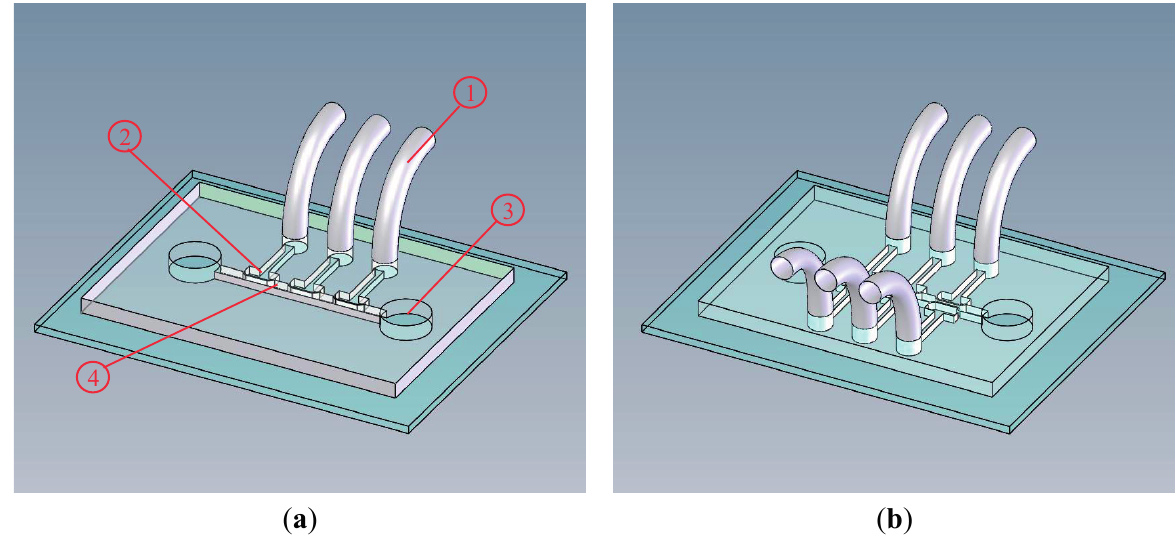
Figure 1. Schematic representation of the proposed micropump using three-pair moving structures in ( a ) single-side mode and in ( b ) double-side mode. Here, (1) is a tubing, (2) is a buried side chamber, (3) is a reservoir, and (4) is a